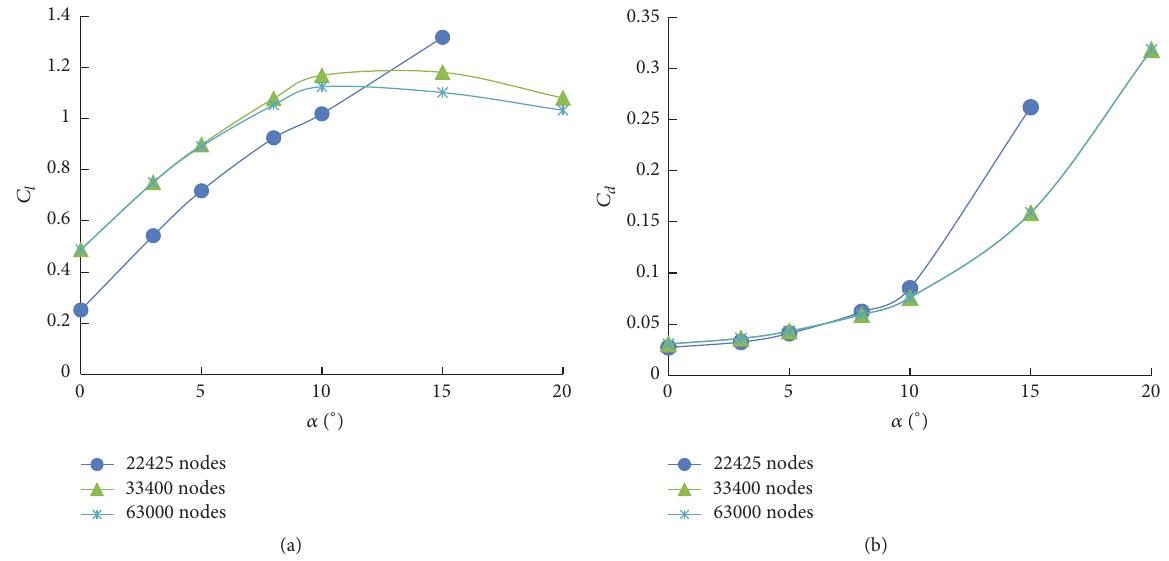
Figure 9: Comparison of simulation results of three grid resolutions of coarse (22425 nodes), medium (33400 nodes), and fine (63000 nodes) meshes at Re = 8 × 10 4 . (a) Lift coefficients ( 𝐶 𝑙 ) and (b) drag coefficients ( 𝐶 𝑑 ).